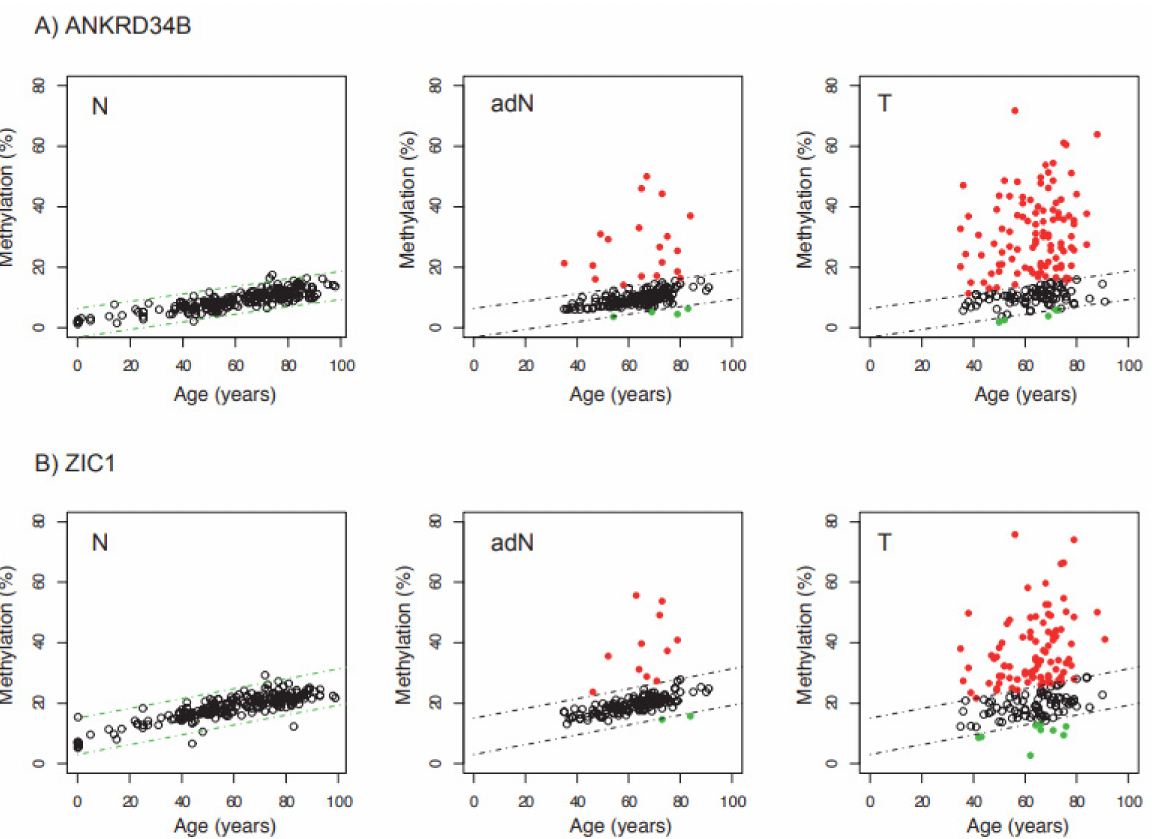
Figure 3. Comparison of age-dependent average methylation observed for CG1-CG7 and CG1-CG3 sites in the ANKRD34B ( A ) and ZIC1 ( B ) candidate gene regions for normal (N), tumor adjacent normal (adN) and tumor (T) kidney tissue samples presenting methylation within 99% prediction channels (dashed lines) of linear regression (open black circles), above upper (solid red circles) and below lower boundaries (green